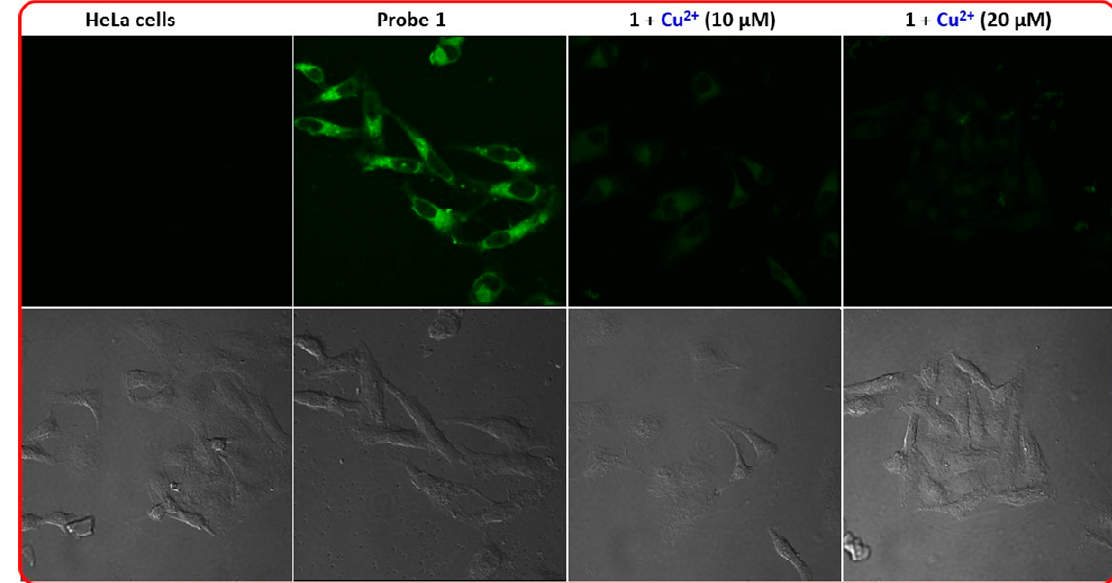
Figure 6. Confocal microscopic images of HeLa cells in the absence and presence of probe 1 and/or Cu 2+ . HeLa cells were preloaded with probe 1 (10 µM) for 30 min and then treated with the desig- Cu 2+ . HeLa cells were preloaded with probe 1 (10 µ M) for 30 min and then treated with the designated nated amount of Cu 2+ (0, 10, or 20 µM), followed by acquisition of fluorescence images under ex- amount of Cu 2+ (0, 10, or 20 µ M), followed by acquisition of fluorescence images under excitation citation at 488 nm. The 1 st panel ( top ) was obtained using a green channel, while the 2nd panel at 488 nm. The 1st panel ( top ) was obtained using a green channel, while the 2nd panel ( bottom ) ( bottom ) corresponds to bright-field images of the cells. corresponds to bright-field images of the